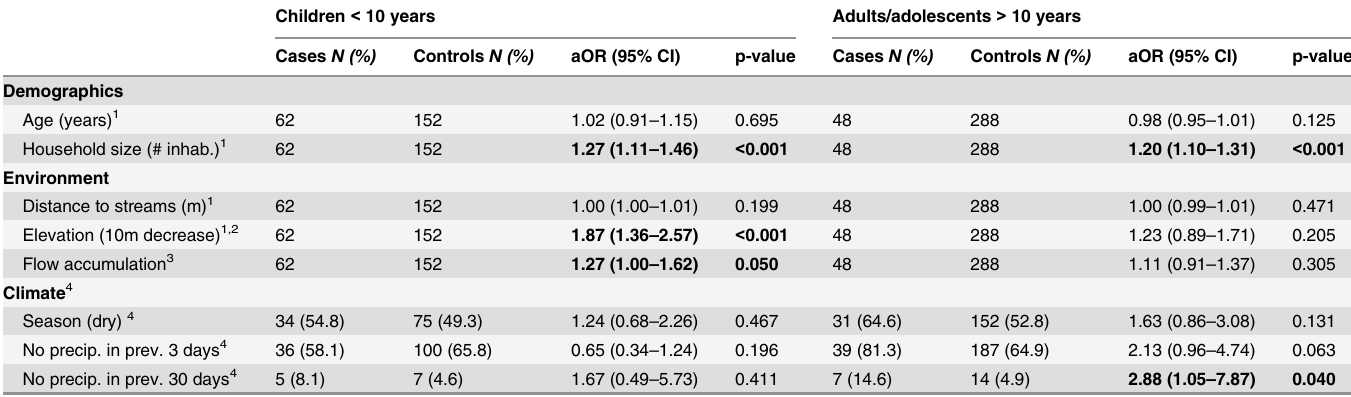
Table 2. Adjusted odds ratios by demographic and environmental